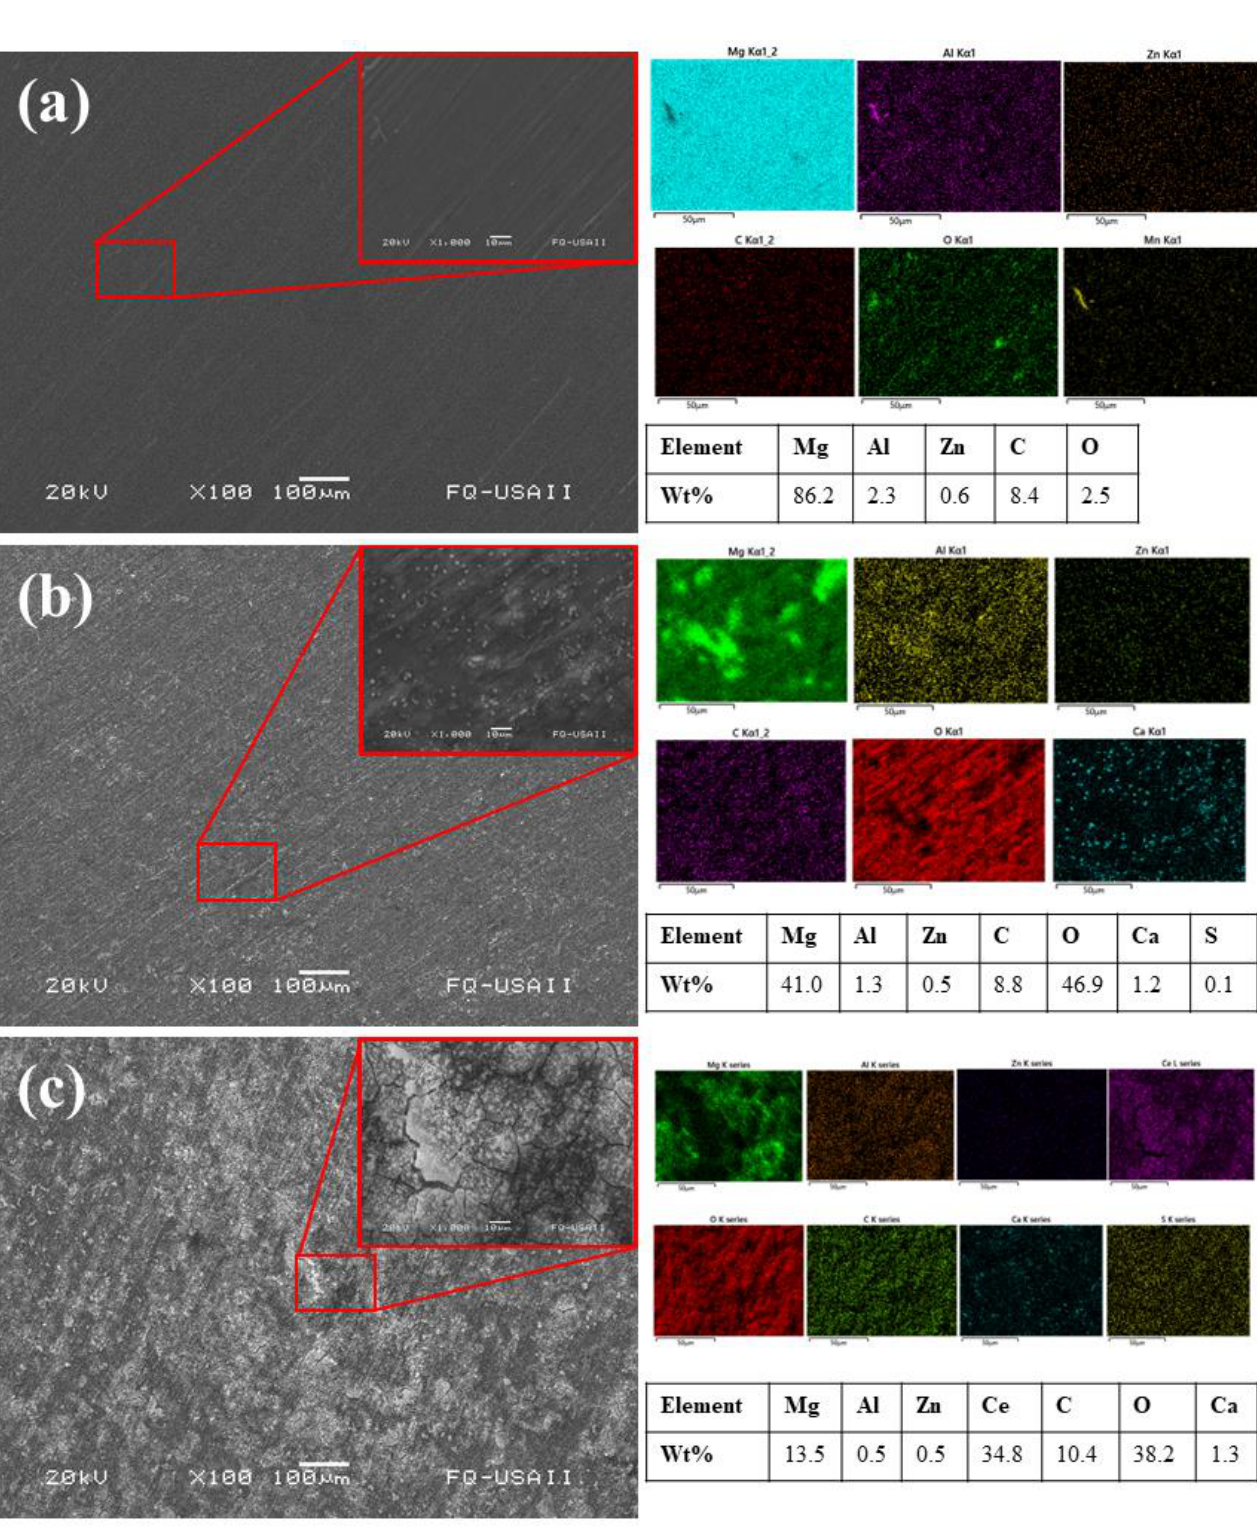
Figure 6. SEM micrography of ( a ) AZ31, ( b ) anodised AZ31OH, and ( c ) AZ31OH-CeO 2